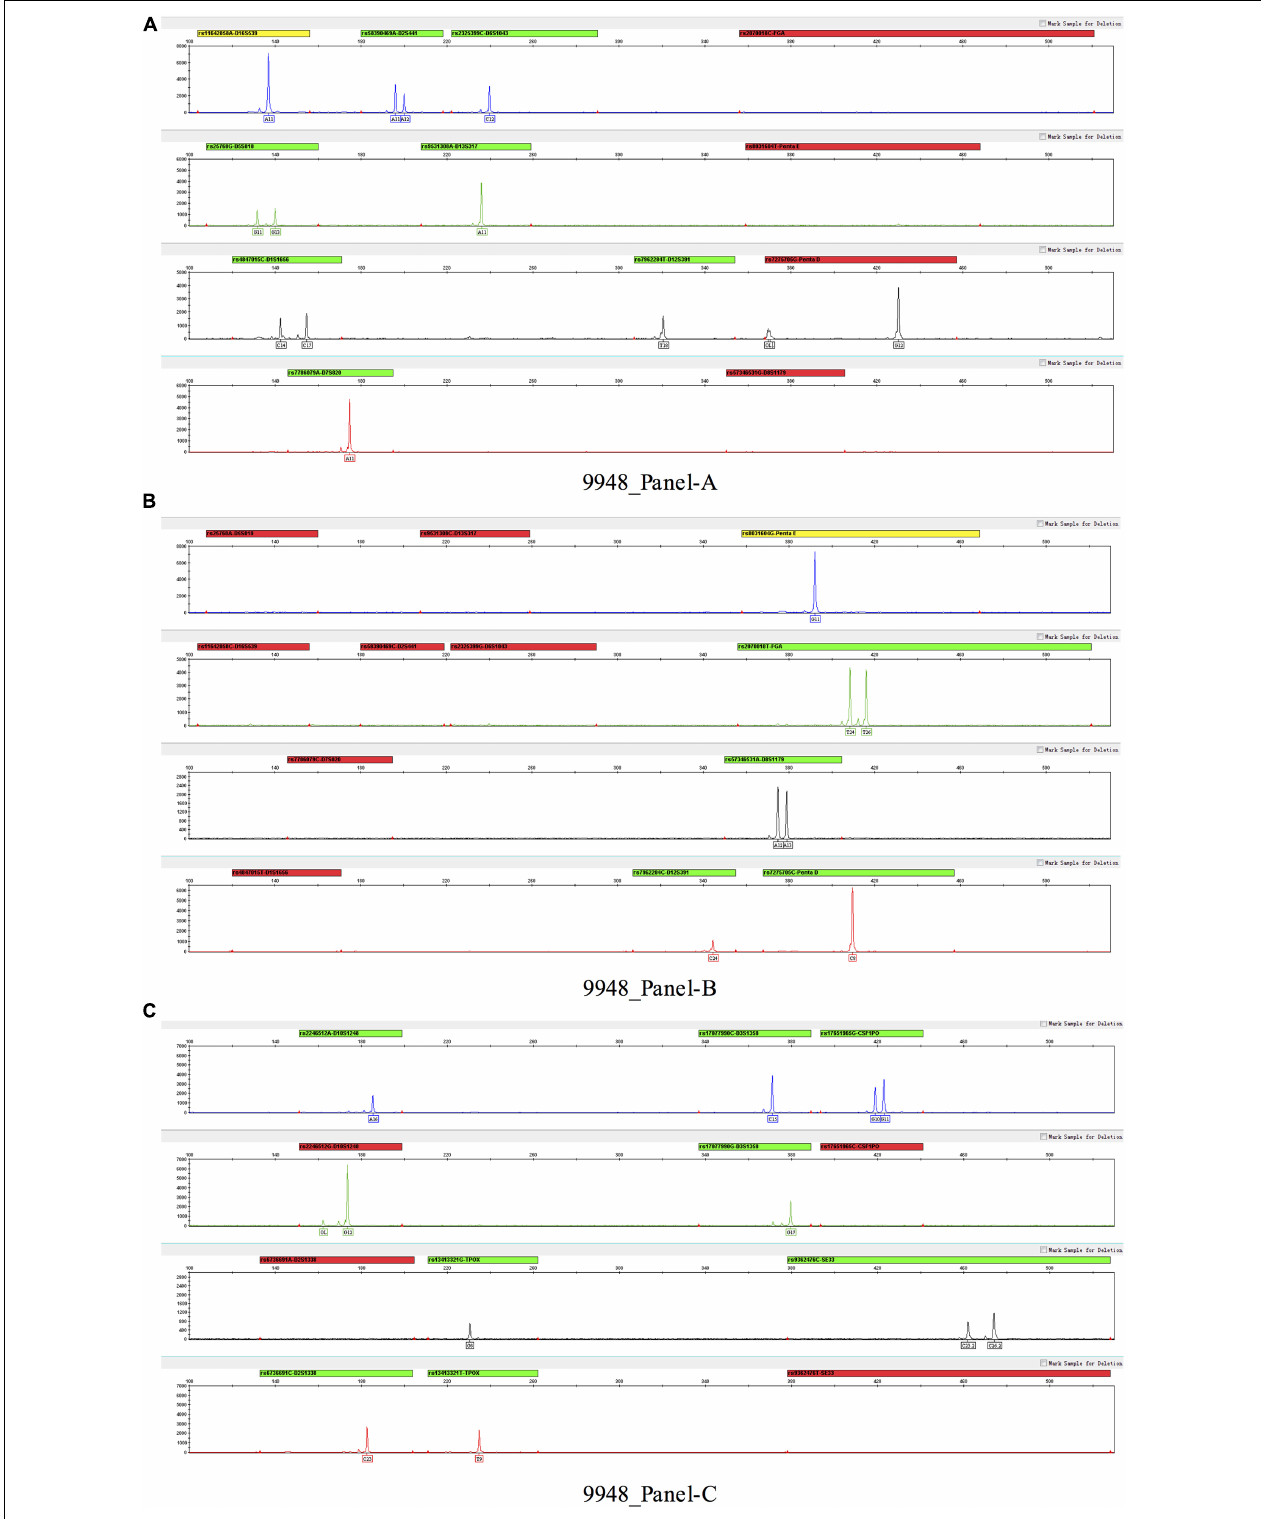
FIGURE 4 | SNP-STR profiles of 9948-control DNA. (A–C) represent three panels ( Panel-A , Panel-B , and Panel-C ) respectively. No allelic peak and a red alert appear for one of the SNP allele-specific primers of a locus, indicating that the SNP genotype of this locus was homozygous for the alternate allele.